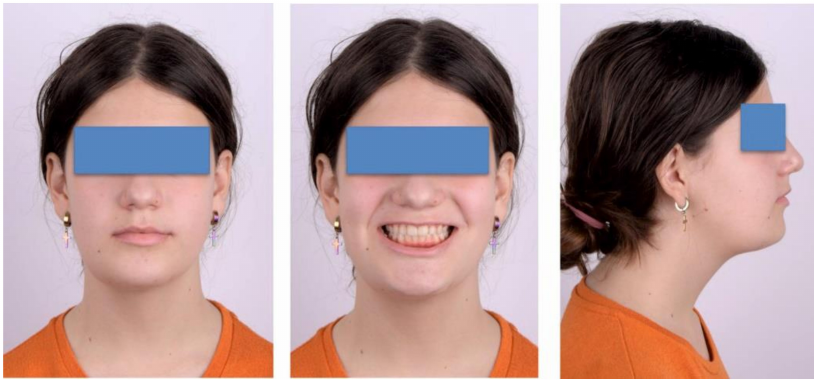
Figure 23. Extra-oral aspect at the one-year follow-up appointment.